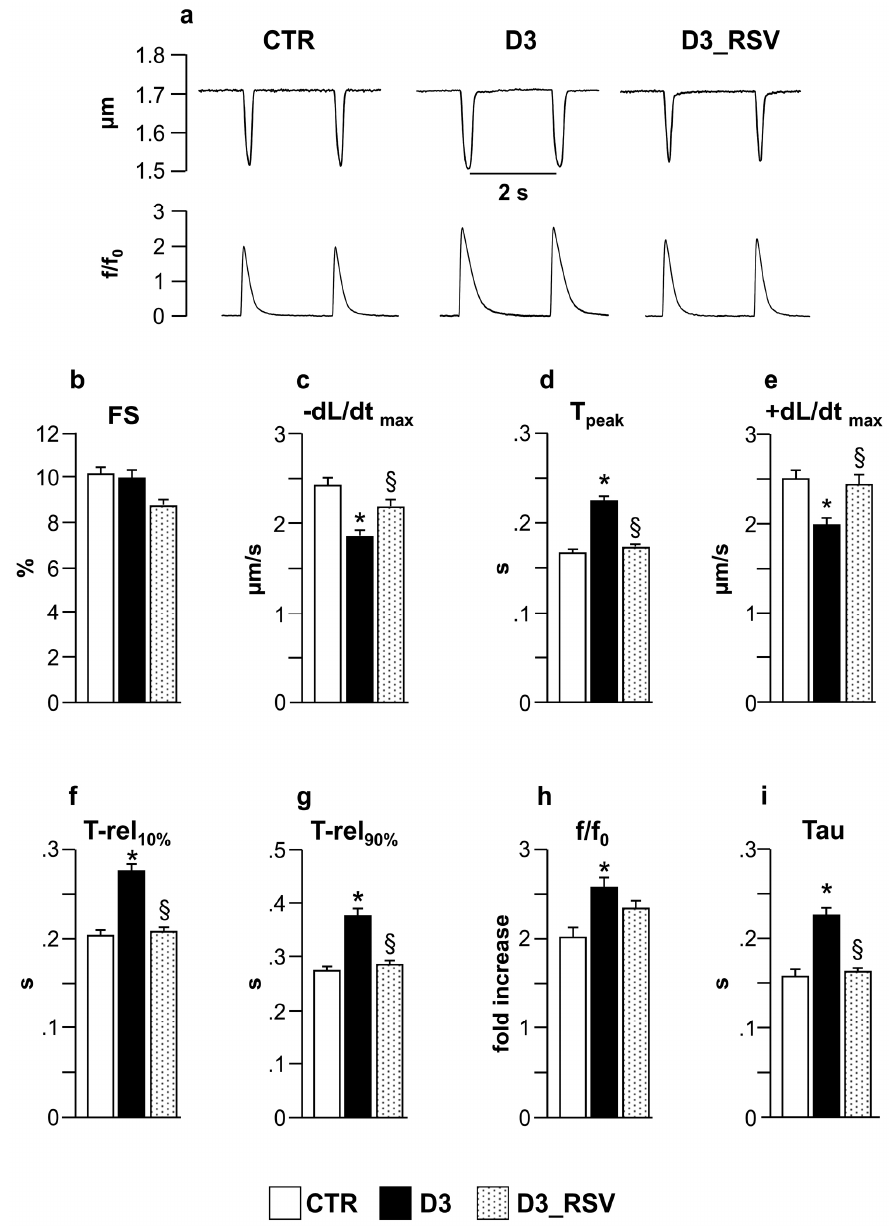
Figure 7. RSV treatment significantly restored cell mechanics and Ca 2+ handling. ( a ) Representative examples of sarcomere shortening and corresponding Ca 2+ transients (normalized traces: fold increase) recorded from CTR, D3 and D3_RSV ventricular myocytes, after three weeks of hyperglycemia; In bar graphs ( b – i ): mean values ± SEM of cardiomyocyte mechanical properties. FS: fraction of shortening ( b ); − dL/dt max : maximal rate of shortening ( c ); T peak : duration of cell contraction ( d ); +dL/dt max : maximal rate of relengthening ( e ); T-rel 10% : time to 10% of relengthening ( f ); T-rel 90% : time to 90% of relengthening ( g ); f/f0: Ca 2+ transient amplitude expressed as peak fluorescence normalized to baseline fluorescence ( h ); and Tau: time constant of the intracellular Ca 2+ decay ( i ). * p < 0.05: significant differences vs. CTR; § p < 0.05: significant differences between D3 and D3_RSV (one ‐ way ANOVA, Games ‐ Howell post ‐ hoc test).